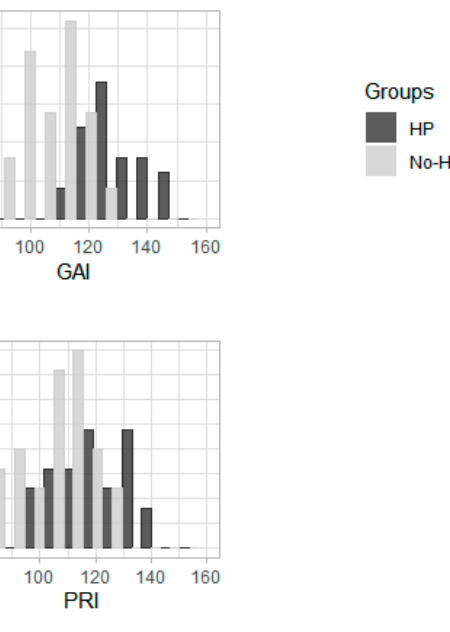
Figure 1. Histograms of intelligence quotient (IQ), GAI, VCI, and PRI in the two groups of children (HP and No-HP).